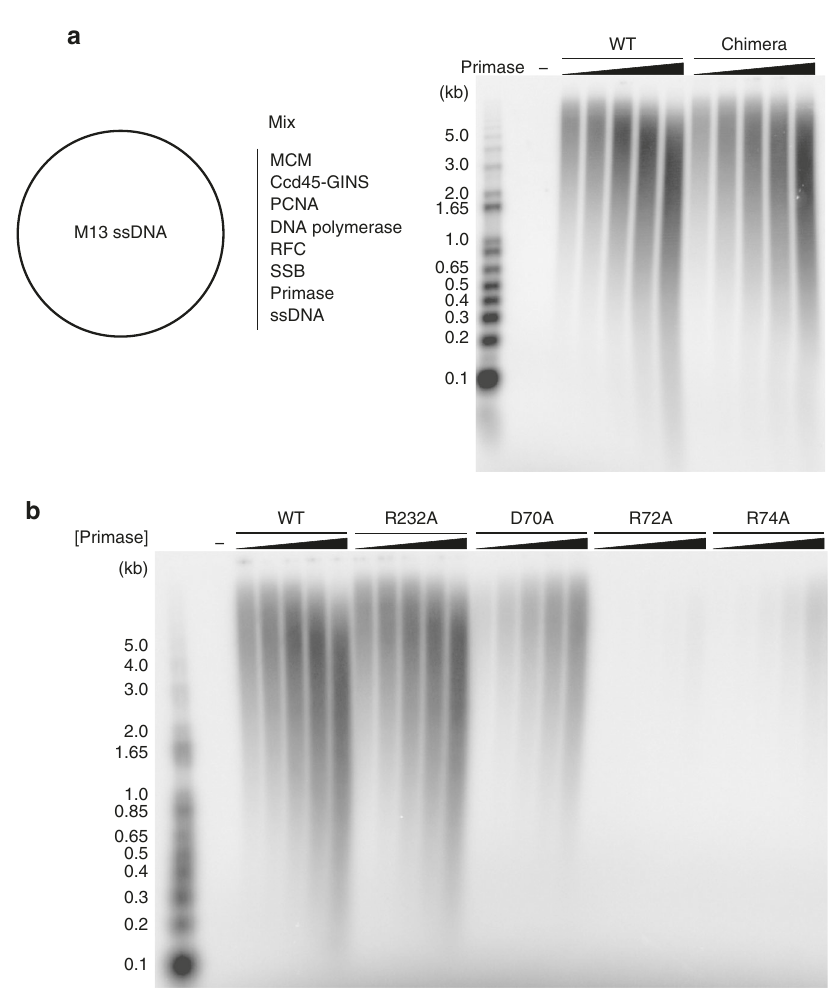
Fig. 5 DNA replication assays. Relative levels of DNA synthesis were measured in a reconstituted DNA replication assay with puri fi ed proteins on a M13 ssDNA template, in the presence of wild-type primase (control) and Chimera ( a ) or wild-type primase (control) and single-point mutants R232A, D70A, R72A and R74A ( b ). The reactions contain 3.125 nM, 6.25 nM, 12.5 nM, 25 nM, or 50 nM primases. The reaction products were separated by alkaline agarose gel electrophoresis and detected by phosphorimaging of the incorporated 32 P- α